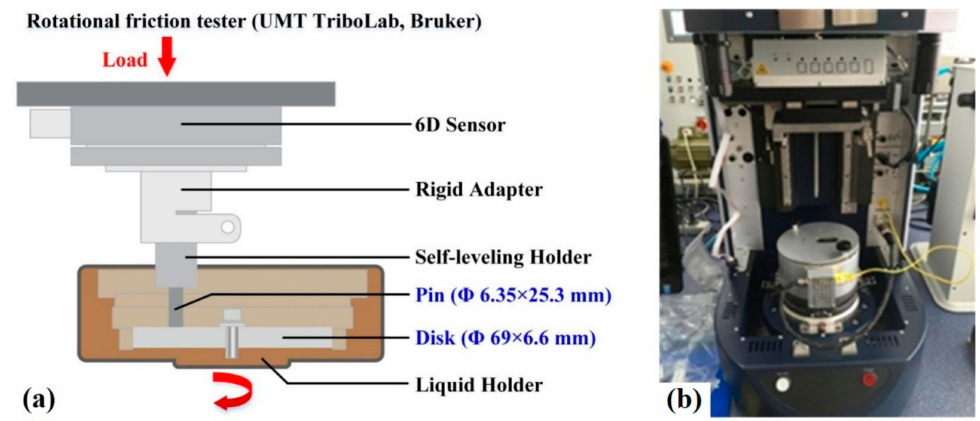
Figure 2. Schematic configuration of the pin-on-disk test: ( a ) schematic diagram; ( b ) real